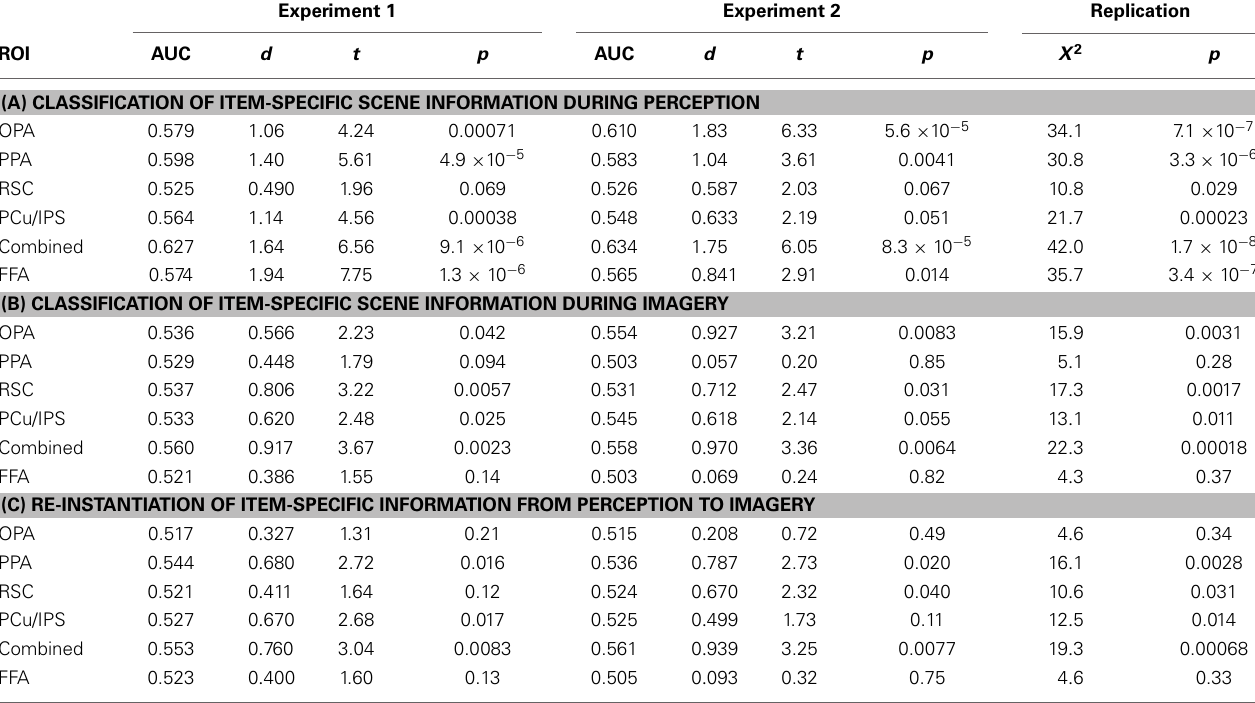
Table 1 | Statistical summary of critical results.